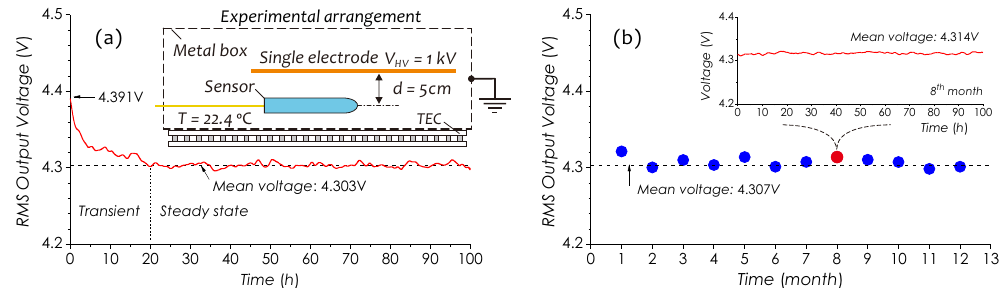
Figure 16. ( a ) Signal trace recorded in first 100 h, ( b ) a collection of all mean voltages of signal traces obtained in every month in a year and inset is a signal trace obtained in 8th